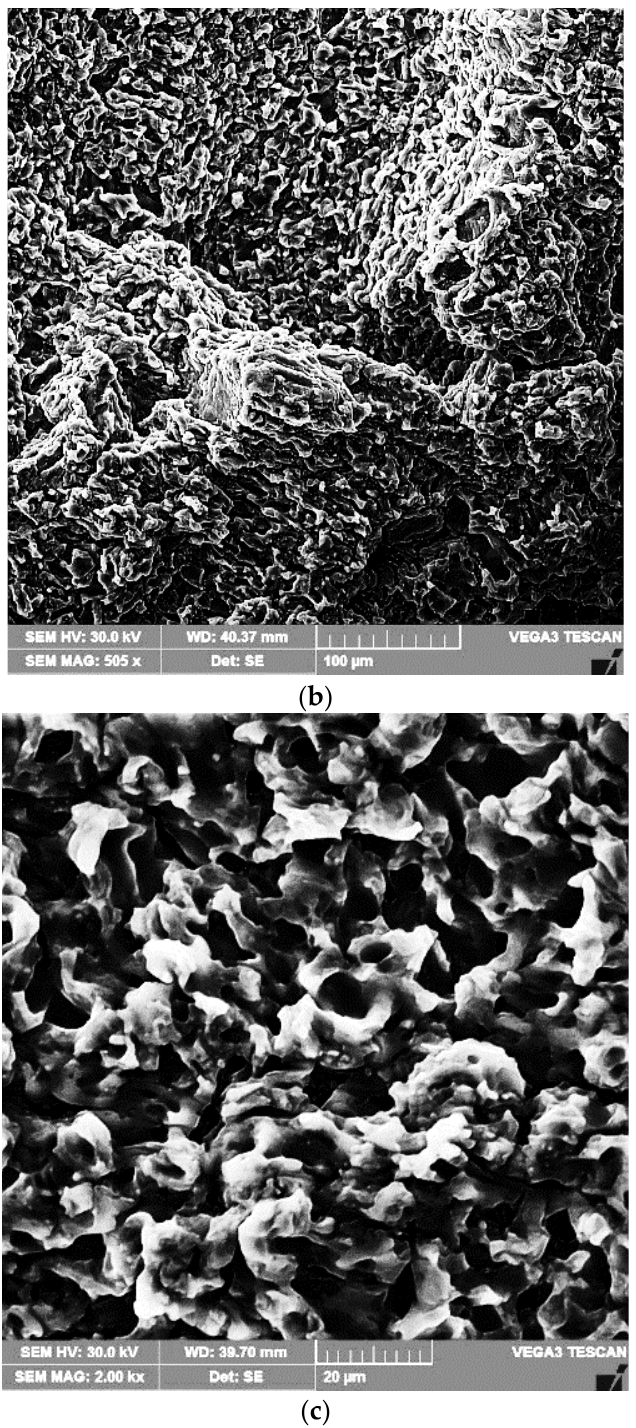
Figure 13. SEM image of the remelted surface, with Is = 200 A, and tested after 165 min for cavitation: ( a ) ×12: ( c ) ×500; ( c ) ×2000.